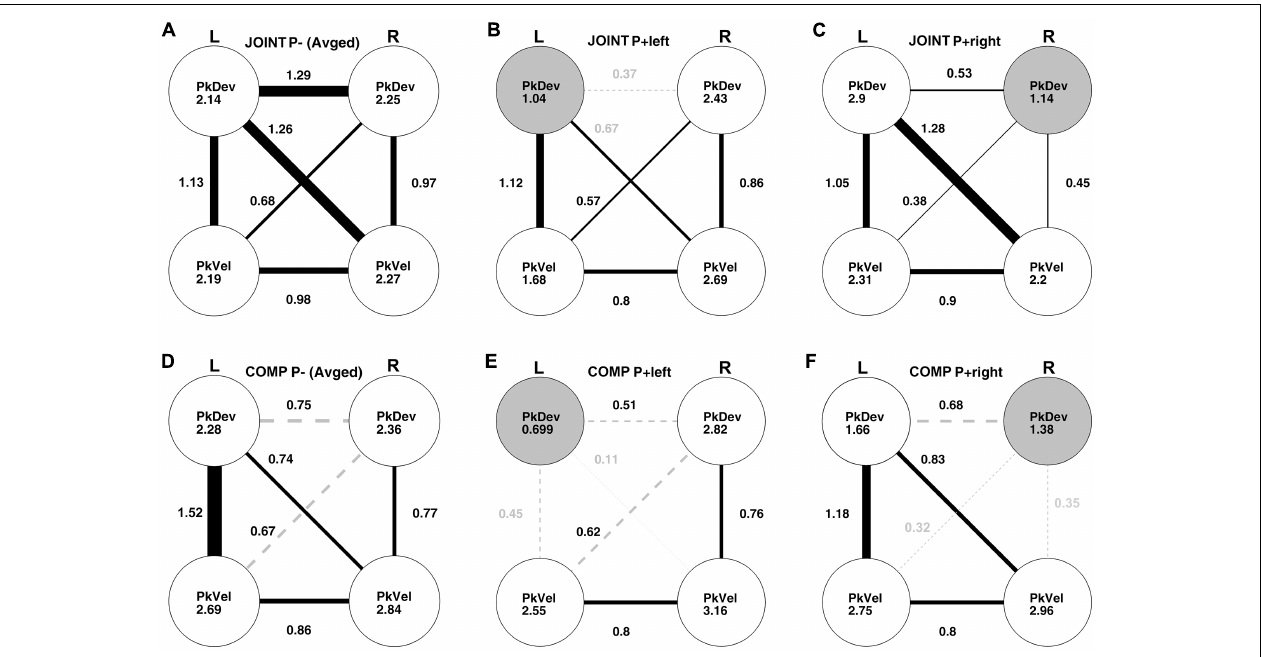
FIGURE 7 | Cross-dyads correlations of kinematic variables: left hand peak deviation (L PkDev), right hand peak deviation (R PkDev), left hand peak velocity (L PkVel), right hand peak velocity (R PkVel). Correlation coefficients were Fisher’s z -transformed before further analyses. The correlations in conditions without perturbations (P–) were averaged. (A) Unperturbed JOINT P– up and down conditions. Coefficients inside disks indicate correlations between “JOINT P– up” and “JOINT P– down” conditions. Edges connecting disks graph correlations between variables for “up” and “down” on average. Line thickness and nearby coefficients reflect correlation sizes. All edges are solid black lines to indicate that they were significant as per bootstrapping analysis. (B) Perturbed JOINT P+ left condition. Same conventions as in panel (A) , except, coefficients inside disks reflect correlations between the left perturbed condition and the average unperturbed conditions; the gray colored disk indicates a significant reduction compared to the “up” vs. “down” correlation in panel (A) . Edges illustrate intercorrelations between variables during the perturbed left condition. Gray coefficients indicate a significant reduction relative to panel (A) . Gray and dashed edges indicate non-significant intercorrelations. (C) Perturbed JOINT P+ right condition. All conventions equivalent to panel (B) . (D) Unperturbed COMP P– up and down conditions. Same conventions as in panel (A) . (E,F) Perturbed COMP P+ left and right conditions, respectively. Same conventions as in panels (B,C) .